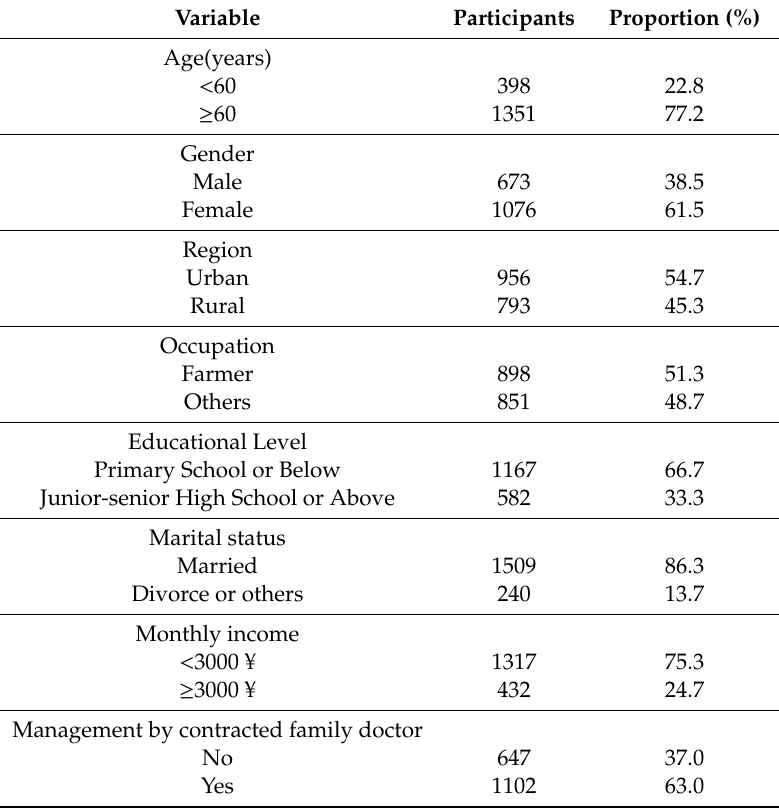
Table 1. Sociodemographic characteristics of study participants (N =